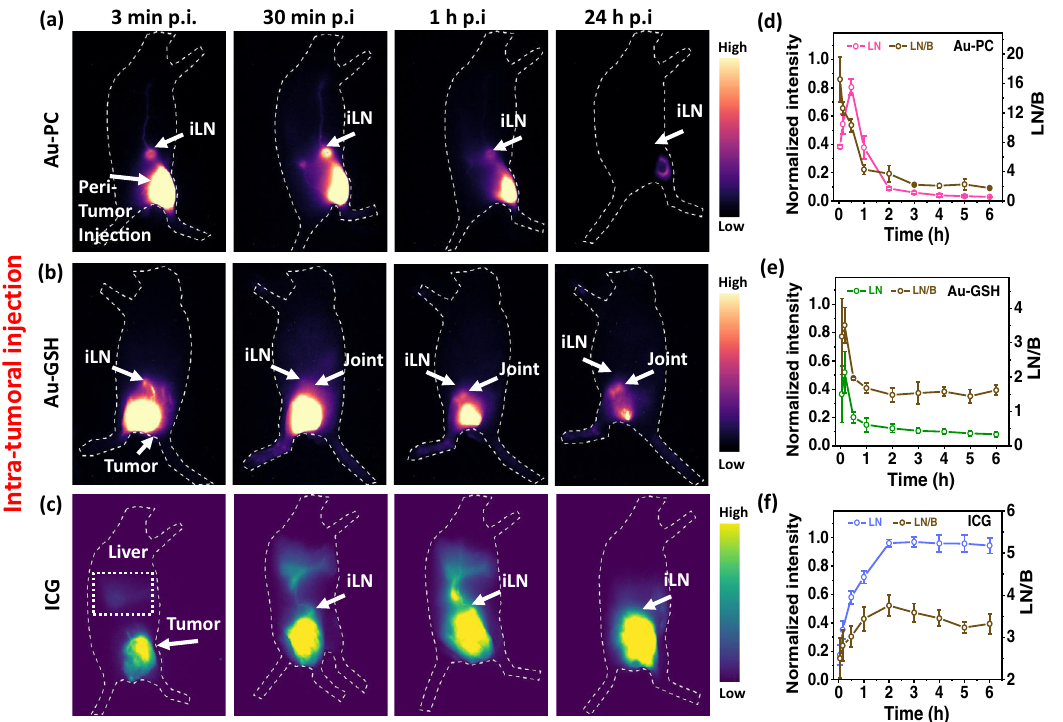
Fig.3|Invivo fl uorescenceimagingwithintra-tumoralinjectedAu-PC,Au-GSH and ICG. Wide- fi eld NIR-II fl uorescence images (excited by an 808nm laser at a power density of 70mW/cm 2 , exposure times 20, 40ms and 4ms for Au-PC, Au- GSH and ICG, respectively, 1100nm long pass fi lter) of (peri)intra-tumoral (i.t.) injected a Au-PCconjugate (1x, ~ 300 µ g), b Au-GSHcluster (1x, ~ 300 µ g) and c ICG (50 µ L, 50mM) probes into a mouse bearing 4T1 tumors on hindlimbs at different